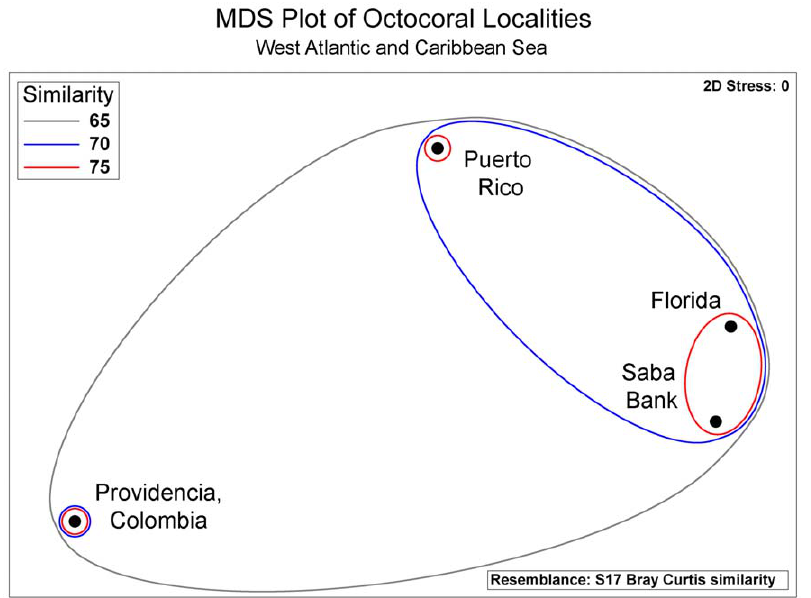
Figure 3. Ordination plot of Caribbean octocoral localities. A non-metric multidimensional scaling (MDS) plot based on Bray-Curtis dissimilarity measures derived from presence and absence of octocoral species in surveys of Florida [9], Colombia [10], and Puerto Rico [11].